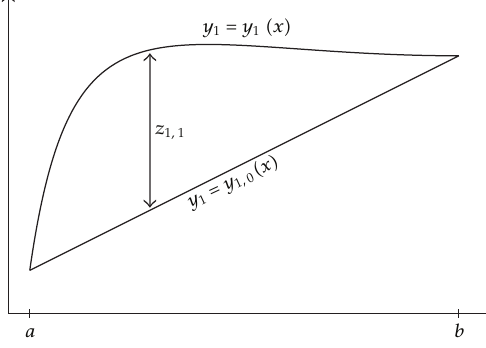
Figure 2: Geometric representation of the function z 1 , 1 (cid:6) x (cid:7)